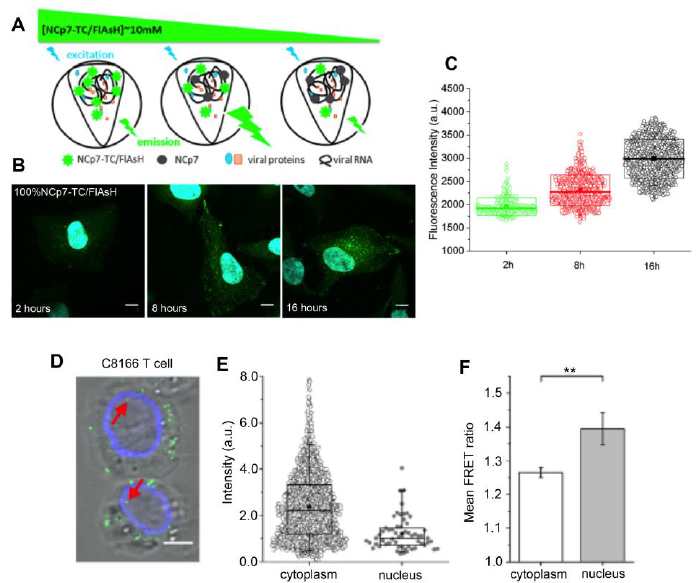
Figure 3. Fluorescence-based monitoring of the cytoplasmic release of viral proteins: ( A ) Principle of FlAsH fluorescence quenching at high concentrations. A decrease in the concentration of labeled NCp7 first results in an increase in fluorescence emission due to the reduction in quenching, followed by a decrease when the quenching effect is no longer present and the number of NCp7 molecules decreases further in the complexes. ( B ) Confocal images of HeLa cells infected by NCp7-TC/FlAsH-containing VSV-G pseudotyped HIV-1 particles at 2, 8, and 16 h.p.i., Scale bar: 10µm ( C ) Fluorescence intensity of individual cytoplasmic viral complexes detected at 2, 8, and 16 h.p.i. The fluorescence increase reflects the loss of quenching during the release of NCp7-TC/FlAsH molecules. (The box-plot represents SD values, the line and the square represent the median and the mean value, respectively (adapted from [22], copyright 2019, Springer Nature)). ( D ) Confocal images of C18166 T cells infected by VSV-G pseudotyped HIV-1 containing IN-GFP (green spots), lamin immunostaining (blue); red arrows indicate viral particles located in cell nuclei ( E ) Intensity of fluorescent spots detected in the cytoplasm and the nucleus (box-plot whiskers represent 5th and 95th percentile, the line and the square depict median and mean value, respectively) ( F ) Mean FRET ratio of HIV-1 pseudoviruses containing IN-mTFP and IN-mVenus in the cytoplasm and the nucleus, ** p-value < 0.05 (reproduced with permission from the Ref. [21] Copyright 2016, Springer Nature).